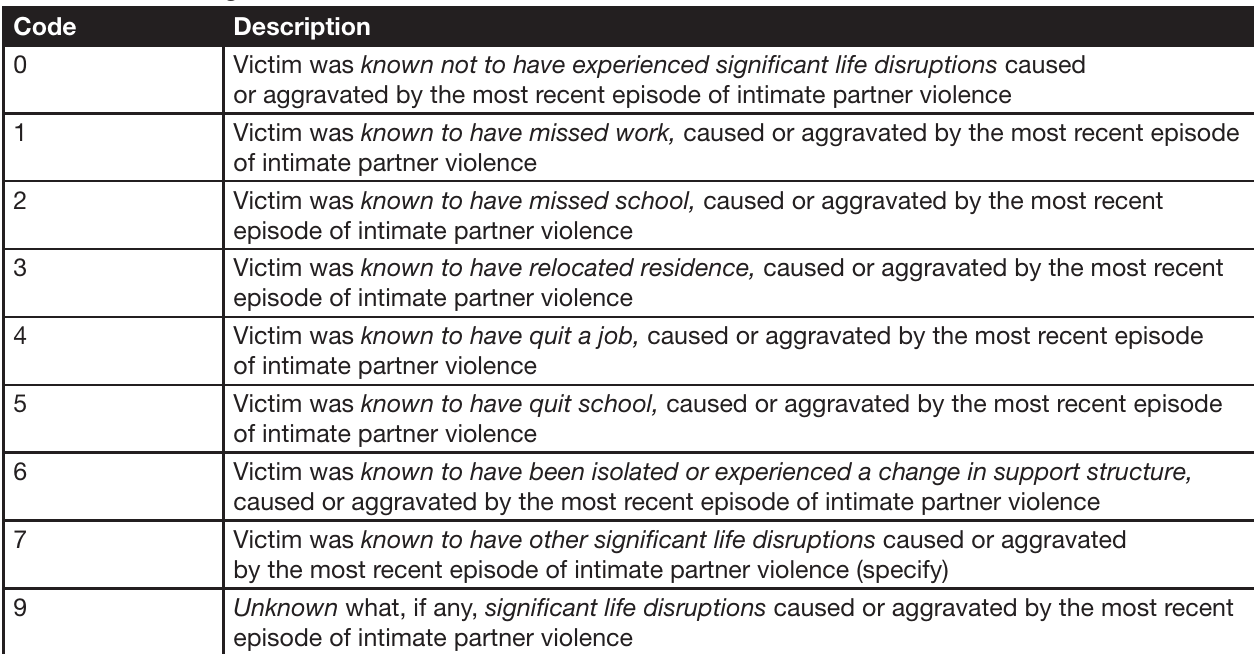
INTIMATE PARTNER VIOLENCE: UNIFORM DEFINITIONS AND RECOMMENDED DATA